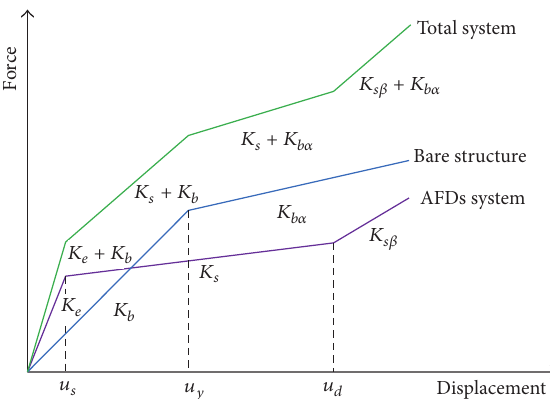
Figure 4: Simplified trilinear characteristic force-displacement for AFD. Figure 5: Load-displacement relationship of container crane with